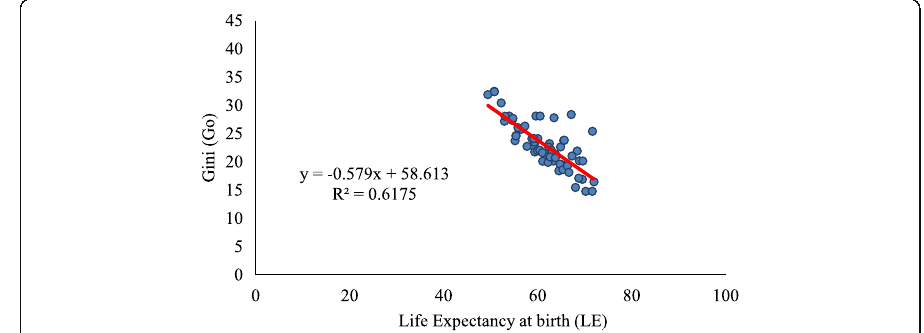
Fig. 1 Relationship between life expectancy at birth and Gini coefficient, men,